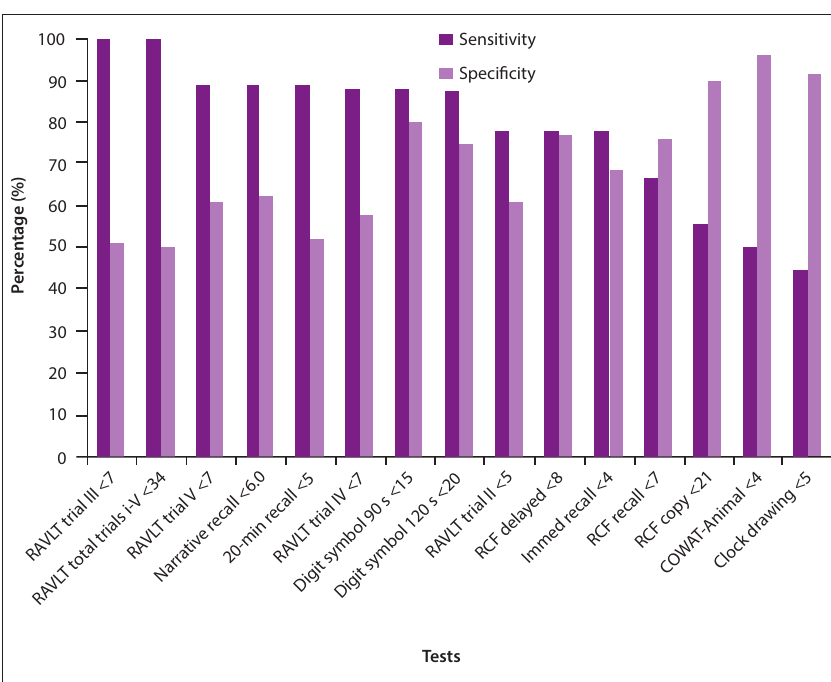
Fig. 1. Optimal sensitivity and specificity of tests for dementia v. non-dementia. (RAVLT = Rey auditory verbal learning tests; RCF = Rey complex figure; COWAT = controlled oral word association test.)